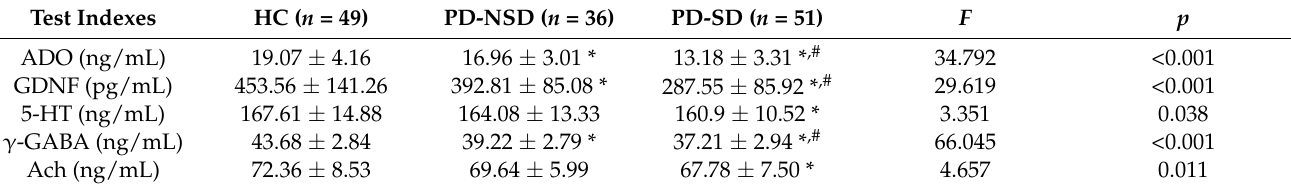
Table 3. The levels of serum detection indexes among groups.